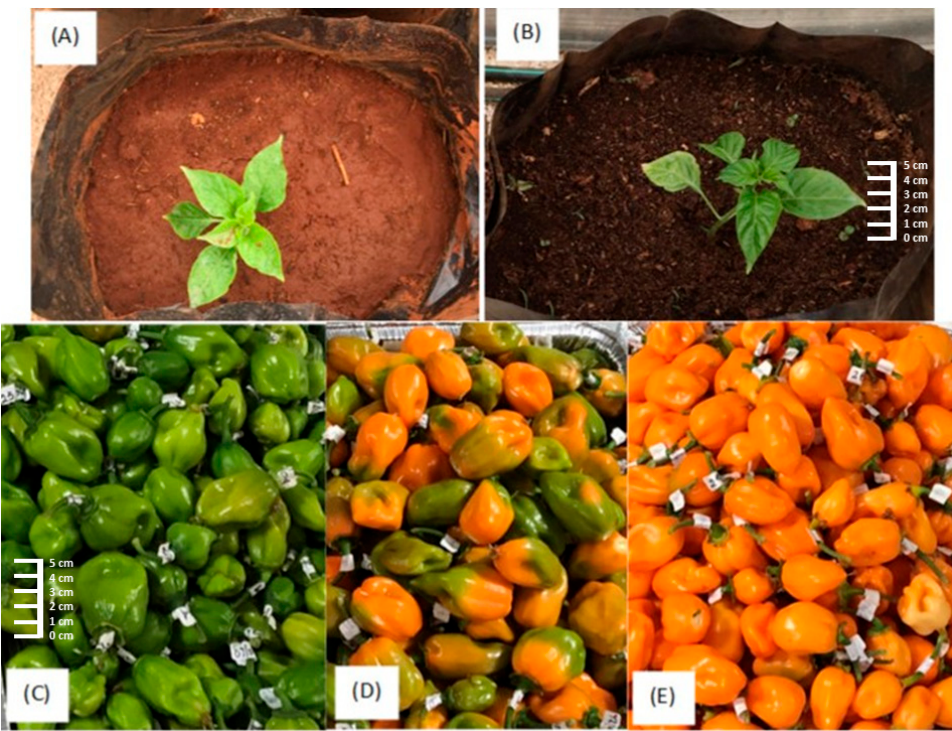
Figure 1. Types of soil used ( A ) red soil, ( B ) black soil, and maturity stages of the analyzed fruits ( C ) unripe (green pepper), ( D ) half ripe (green-orange pepper) and ( E ) ripe (orange pepper). For fertilization, the methodology of Medina-Lara et al. [23] was used, which is rec- ommended for Habanero peppers cultivated in soils of Yucatan to develop an adequate production of fruits. Fertilizer Triple 18 Ultrasol ® (SQM, Santiago de Chile, Chile) com- posed of nitrogen, phosphorus, and potassium at a concentration of 18% was used after 10 post-transplant days (PTD). The fertilizer was applied by irrigation with water (1 L) twice a week. The micronutrients (B, Ca, Cu, Co, Fe, Mn, Mo, Mg and Zn) were sprayed on the leaves once a week with commercial product Bayfolan ® Forte (Bayer CropScience, Mexico City, Mexico) diluting 24 mL in 16 L of water. After 20 PTD and before floral initiation, a growth regulator containing gibberellin, cytokinin and auxin (Biozyme ® -TF, Arysta LifeScience, Guatemala City, Guatemala) was sprayed (16 mL diluted in 16 L of water) once a week. Irrigation was applied twice a week during the first 15 days after post-